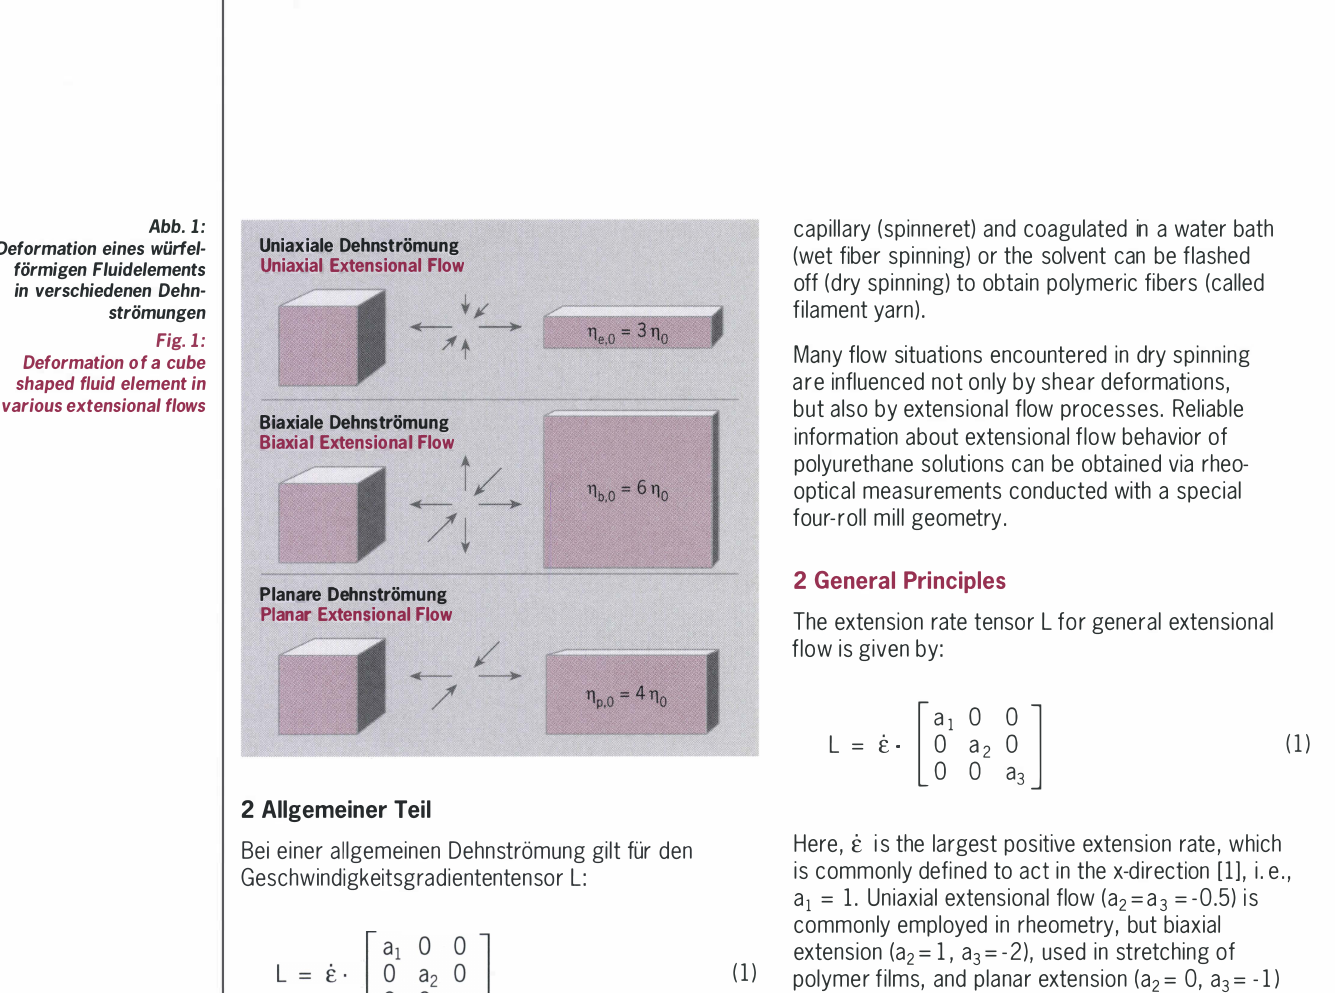
Fig.l: Deformation of a cube shaped fluid element in various extensional flows Biaxiale Dehnstromung Biaxial Extensional